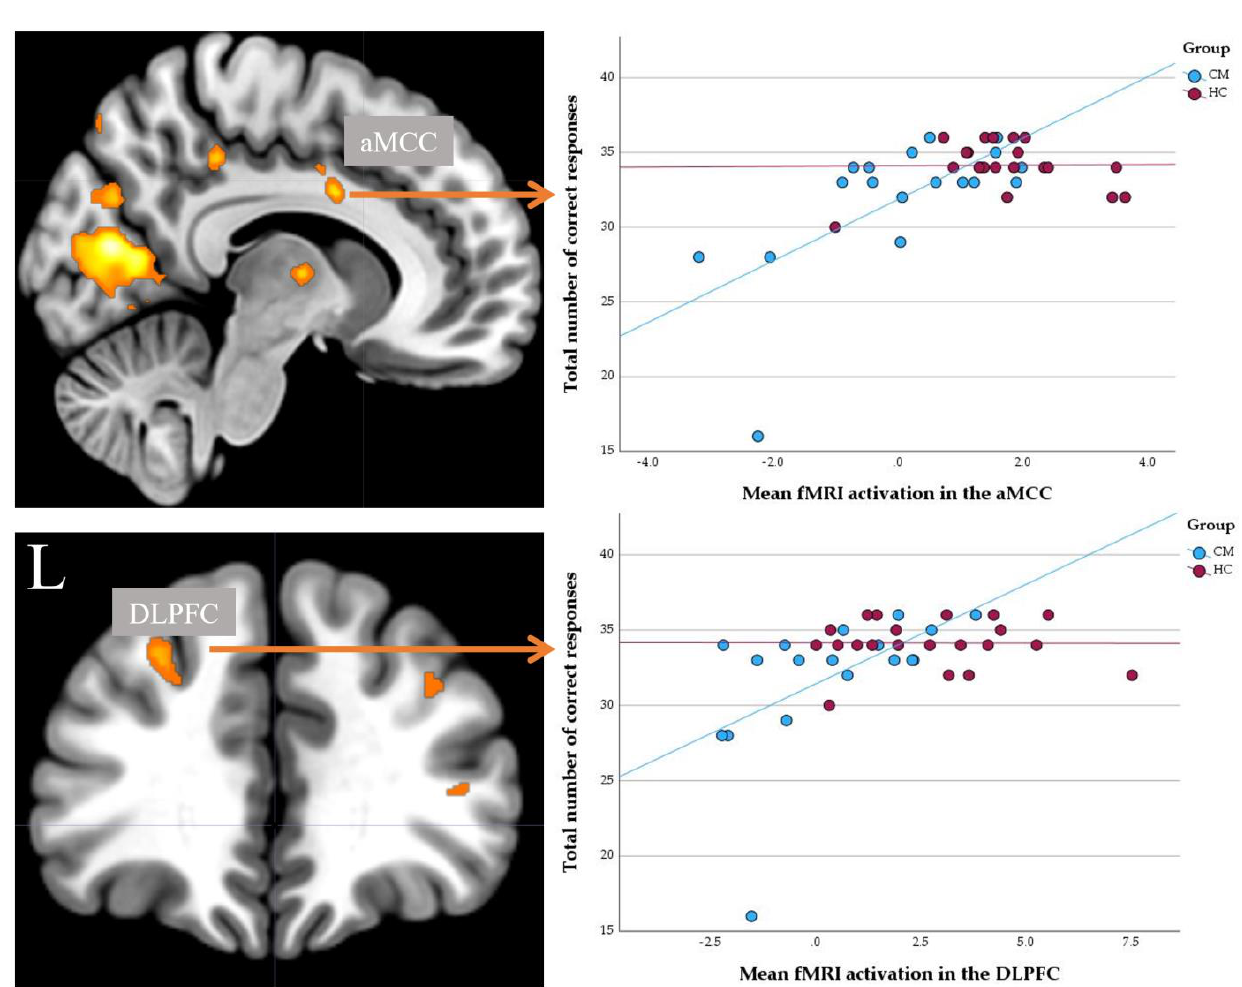
Figure 2. The scatterplot depicts significantly positive correlations between the fMRI signal in the aMCC (individuals with MA dependence: r = 0.57, p < 0.01), left DLPFC (individuals with MA dependence: r = 0.57, p < 0.01), and the total number of correct responses in individuals with methamphetamine dependence (MA; blue color) and healthy controls (HC; red